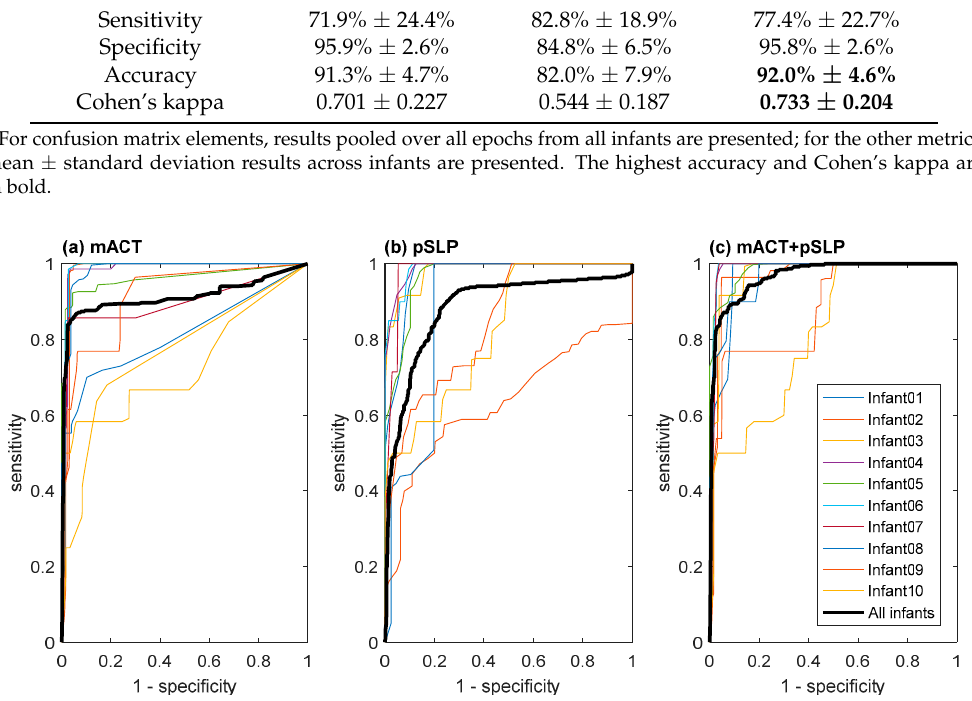
Figure 4. Receiver operating characteristic (ROC) curves of each infant and all epochs pooled over all infants obtained, based on the proposed wake and sleep classification model using three different feature sets ( a ) mACT, ( b ) pSLP, and ( c ) mACT + pSLP, where the area under the curve (AUC) for all infants is 0.902, 0.877, and 0.952.